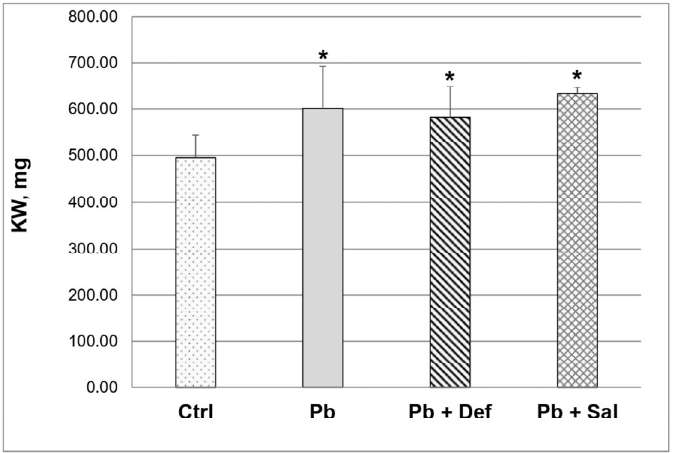
Figure 2. Kidney weight (KW) in control, Pb-intoxicated mice and Pb-intoxicated mice with subsequent treatment with deferiprone and/or salinomycin, n = 10. Asterisks denote a significant difference at p < 0.05 compared to the untreated mice.